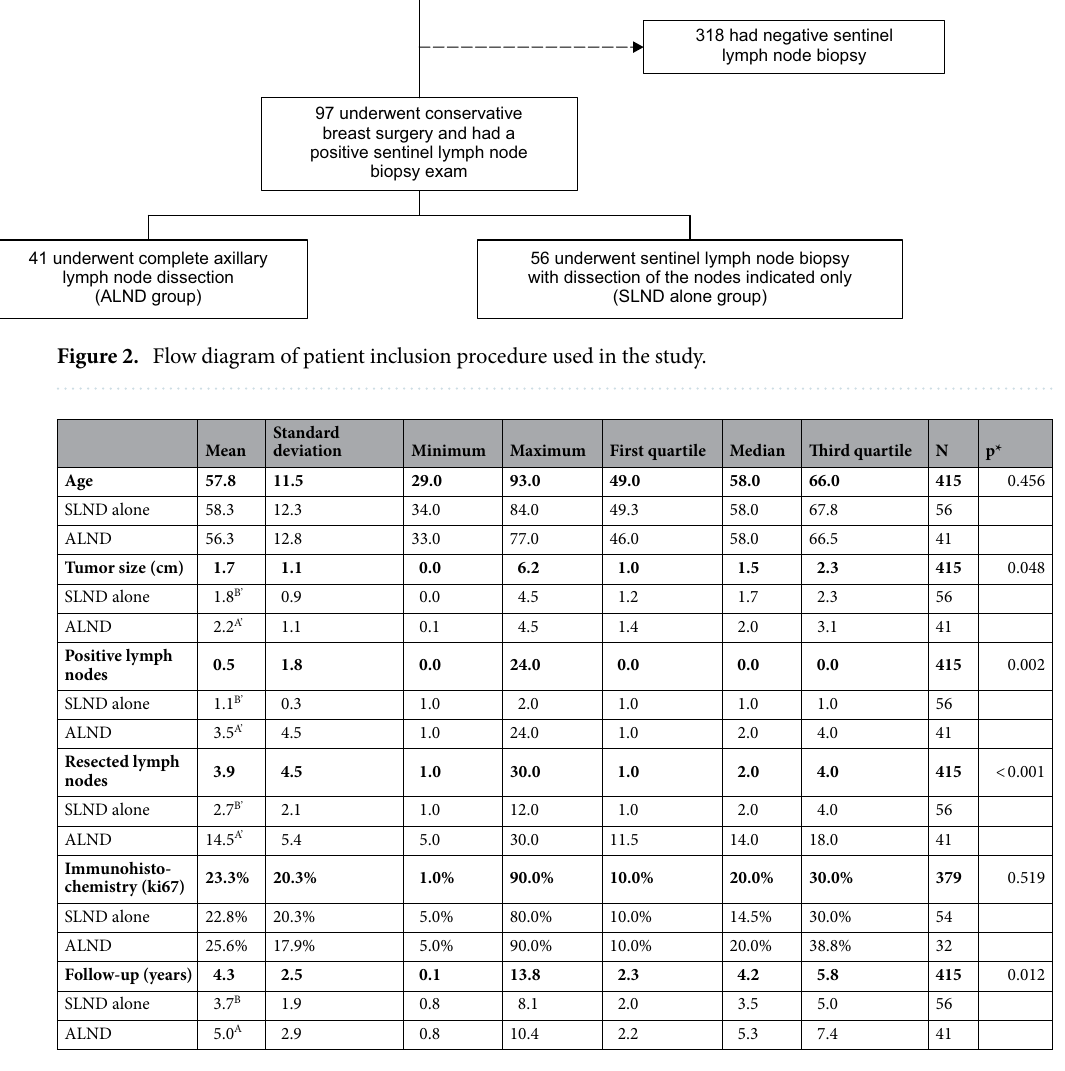
Table 1. Baseline clinical characteristics and follow-up in patients with breast cancer. Bold values indicates category headings and the total value of the category by group. (A) and (B) are different means according to the multiple comparisons of Duncan. (A’) and (B’) are different means according to the multiple comparisons of Dunn–Bonferroni. ALND complete axillary lymph node dissection, SLND sentinel lymph node dissection. *Student’s t test for comparison of mean values between two